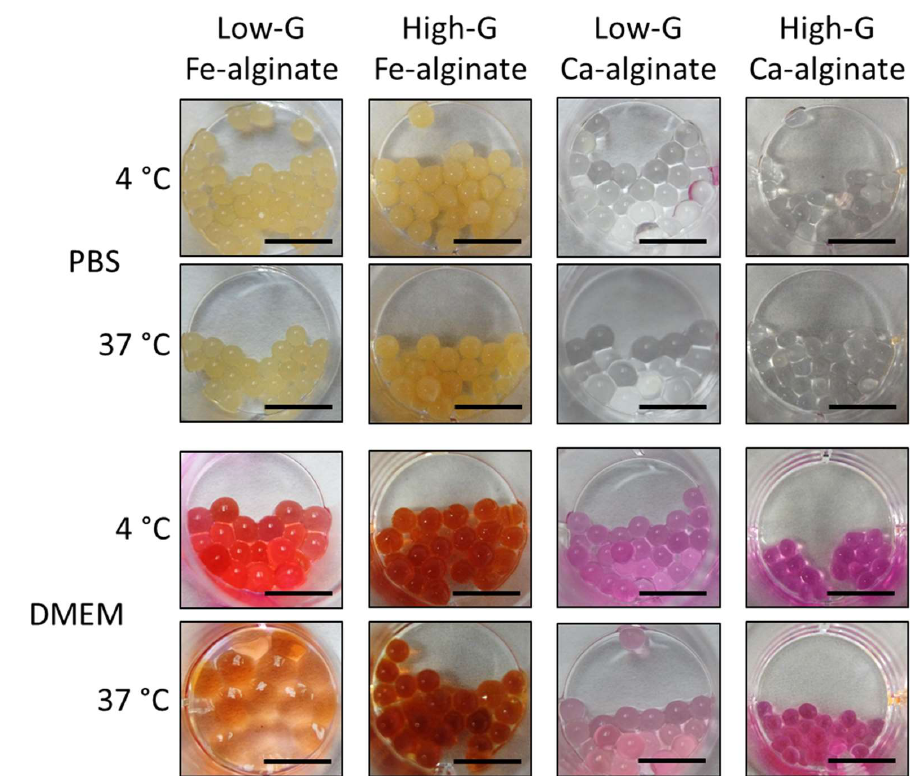
Figure 3. Swelling and stability of Fe-alginate and Ca-alginate beads with different M/G ratios in PBS or DMEM culture medium after one week of incubation at 4 °C or 37 °C. At day 0, all beads showed size and aspect similar to High-G Ca-alginate beads incubated in DMEM at 37 °C. Beads incubated in DMEM appeared red because of internalization of the phenol red present in DMEM. Scale bar: 10 mm.